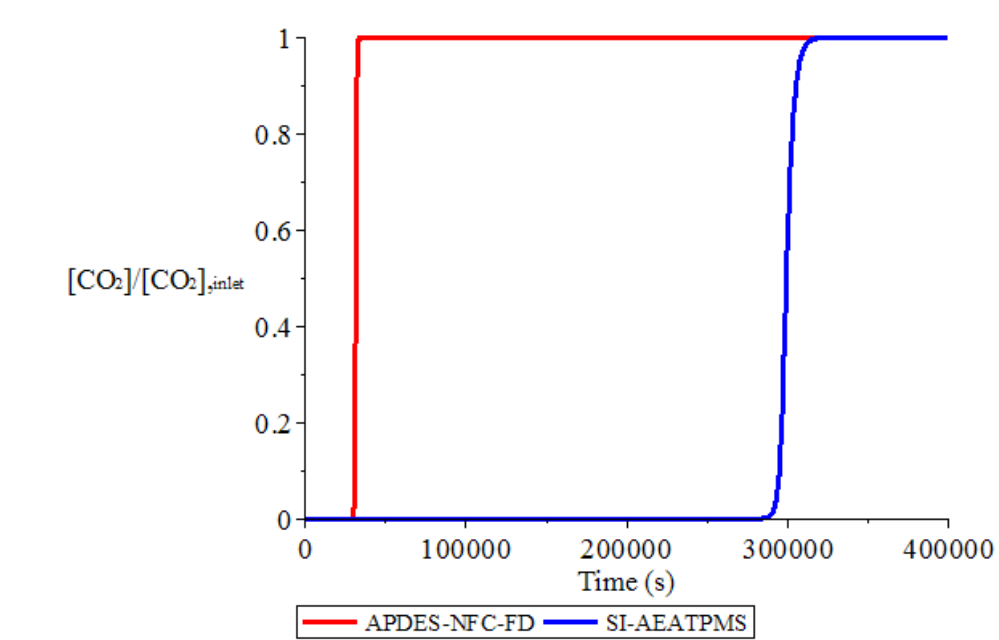
Figure 4. Breakthrough curves (CO 2 concentration at the outlet/CO 2 concentration at the inlet) for chemisorbents .